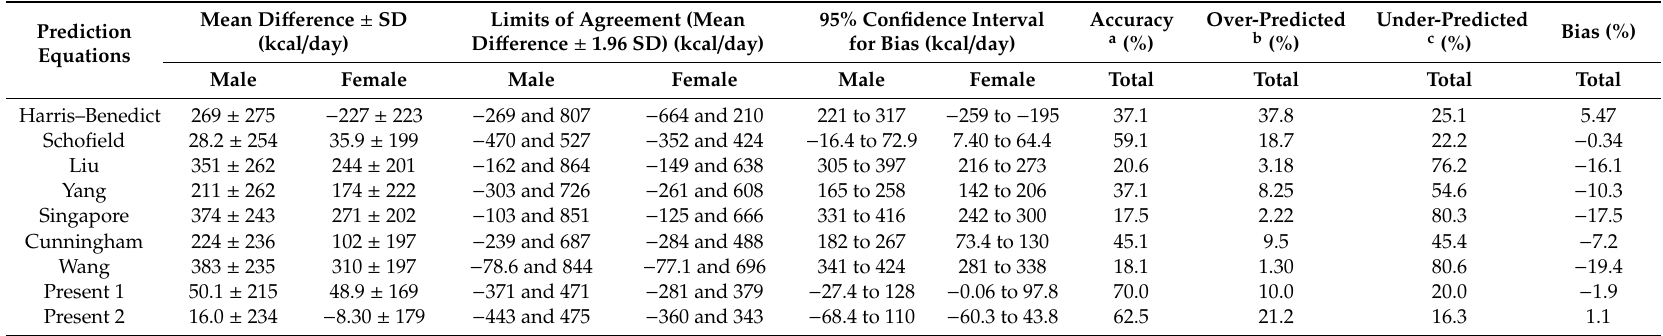
Table 4. Agreement between measured RMR and predicted